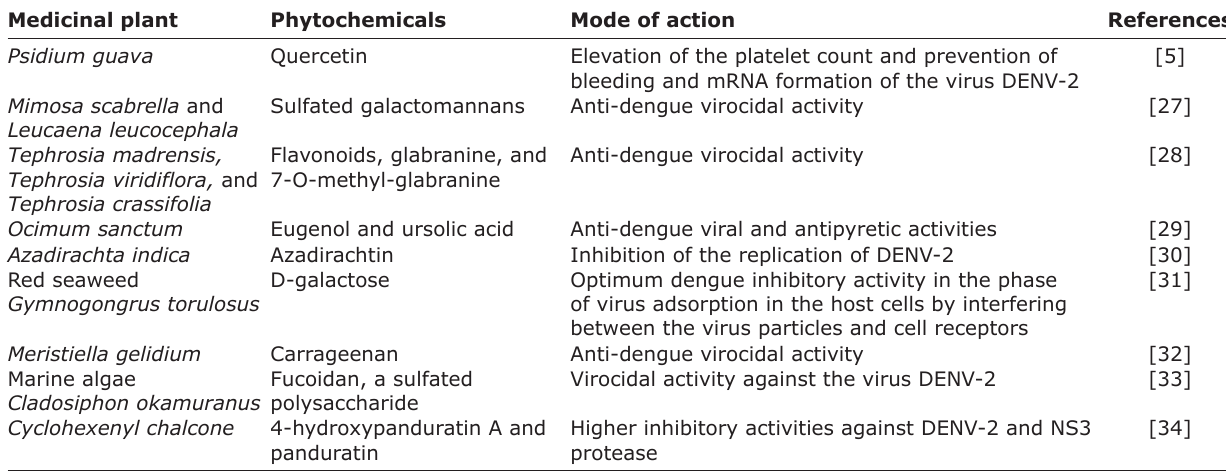
Table-2: Mode of action of phytochemicals extracted from medicinal plants. Medicinal